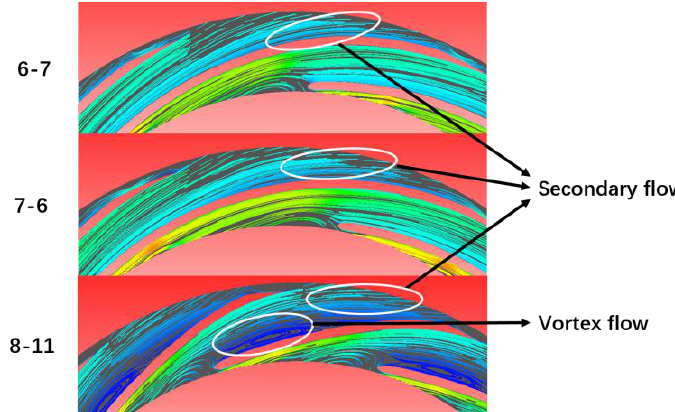
Figure 12. Enlarged velocity streamline on stay vane.